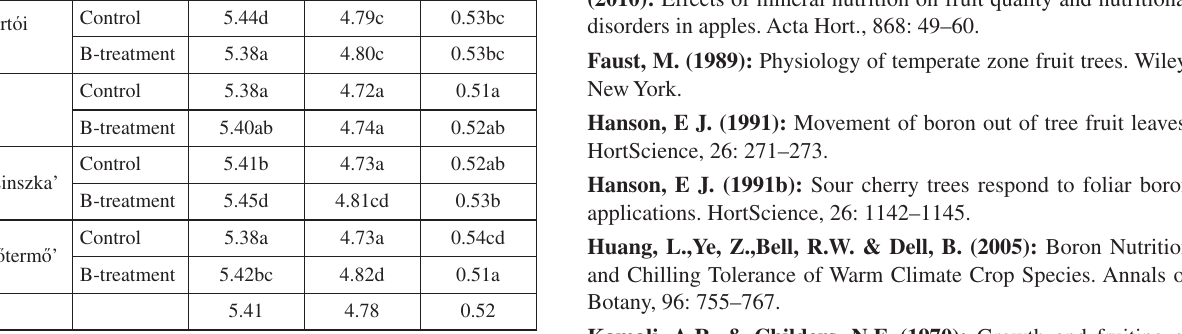
Table 6: Results of fruit analysis II. (sugars) (Újfehértó, Hungary, 2008) (P<0.05).Cultivars